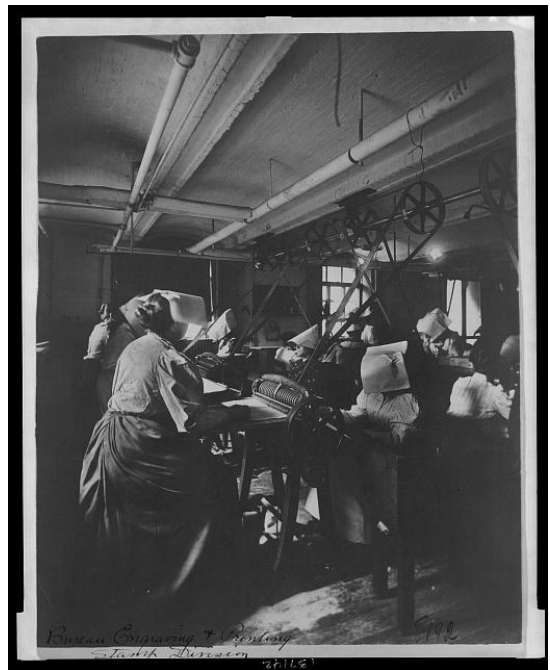
Figure 23. Frances Benjamin Johnston. 1895. Women perforating sheets of stamps in the Stamp Division at the Bureau of Engraving & Printing. Library of Congress.